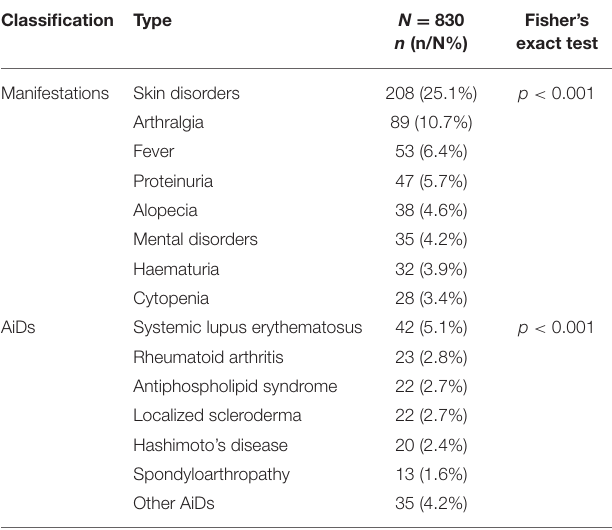
TABLE 5 | Prevalence of several pathological conditions in cases with the DFS staining pattern vs. other ANA patterns. Pathological condition ANA ( + ) n DFS pattern